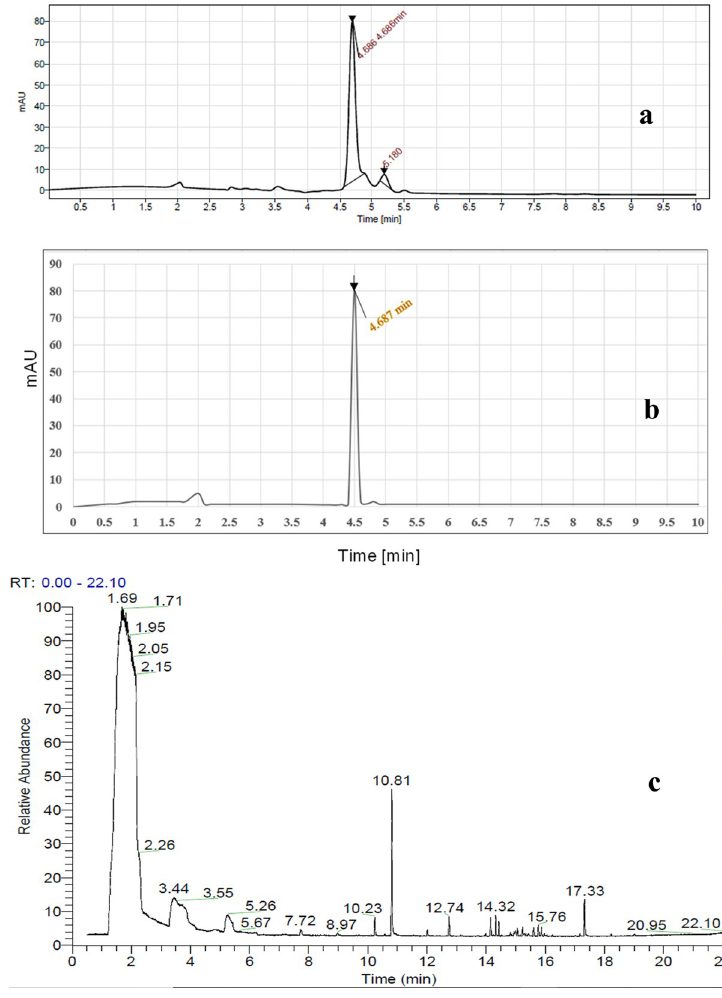
Fig 6. a HPLC chromatogram of antibacterial fraction of LCS1 extract obtained using a C18 reverse phase column and gradient elution was used with the mobile phase composed of (A) acetonitrile–water–phosphoric acid (19:80:1) and (B) acetonitrile with a flow-rate of 0.8 mL/min. Fig 6B HPLC chromatogram of standard bisabolol chemical Fig 6C Full scan chromatographic profile obtained from the bioactive fraction (antibacterial) of endophytic fungi Colletotrichum alatae